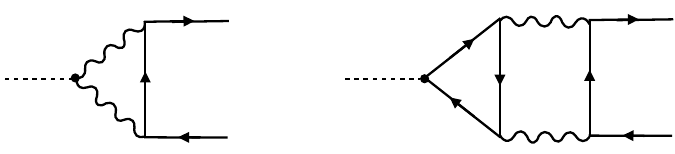
Figure 2 . Examples of one-loop and two-loop diagrams contributing at the same order in pertur- bation theory if c V V and c F have similar